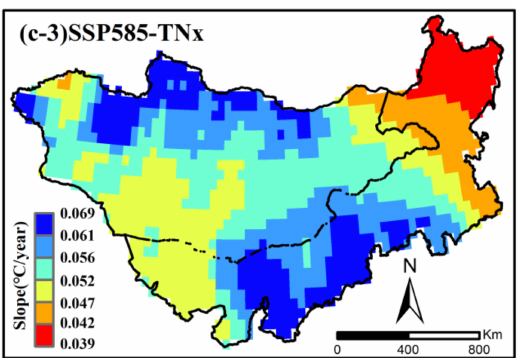
Figure 12. Spatial trends of extreme climate indices for different SSP scenarios across the Mongolian Plateau during 2021–2080.(( a1 – a3 ): Spatial trends of R20 (Number of moderate precipitation days) in the SSP126/SSP245/SSP585 scenario, ( b1 – b3 ): Spatial trends of SU25 (Hot summer days) in the SSP126/SSP245/SSP585 scenario, ( c1 – c3 ): Spatial trends of TNx (An extremely high daily minimum